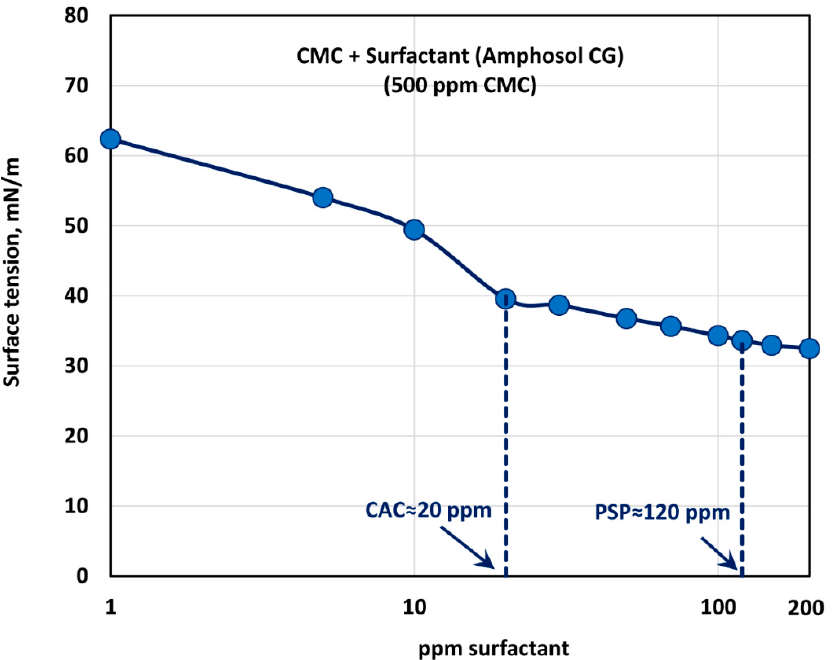
Figure 19. Variation of surface tension of surfactant-polymer solutions with the increase in surfactant (Amphosol CG) concentration, at a fixed polymer (CMC) concentration of 500 ppm.